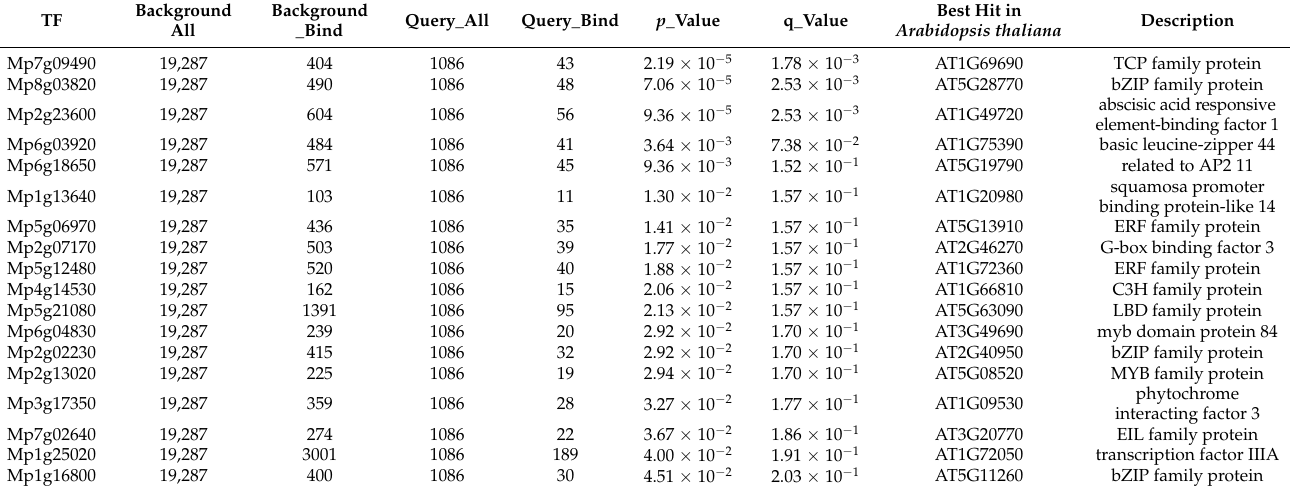
Figure 3. Differential response genes (DRGs) in WT and Mp cry mutant plants grown under BL and WL conditions and GO enrichment analysis. ( A ) Principal component analysis (PCA) of transcriptome changes of between WT and Mp cry under different light treatments. ( B ) Venn diagram showing overlaps of DEGs (Blue_vs_White) in WT and Mp cry . Genes with a fold change ratio (Blue_vs_white) > 1.5 or <0.67 and a p value < 0.05 as deferentially expressed genes (DEGs). ( C ) GO enrichment analysis of 1084 DRGs between WT and Mp cry . Table 1. 18 transcription factor genes possessing significantly over-represented targets in the 1086 DRGs.